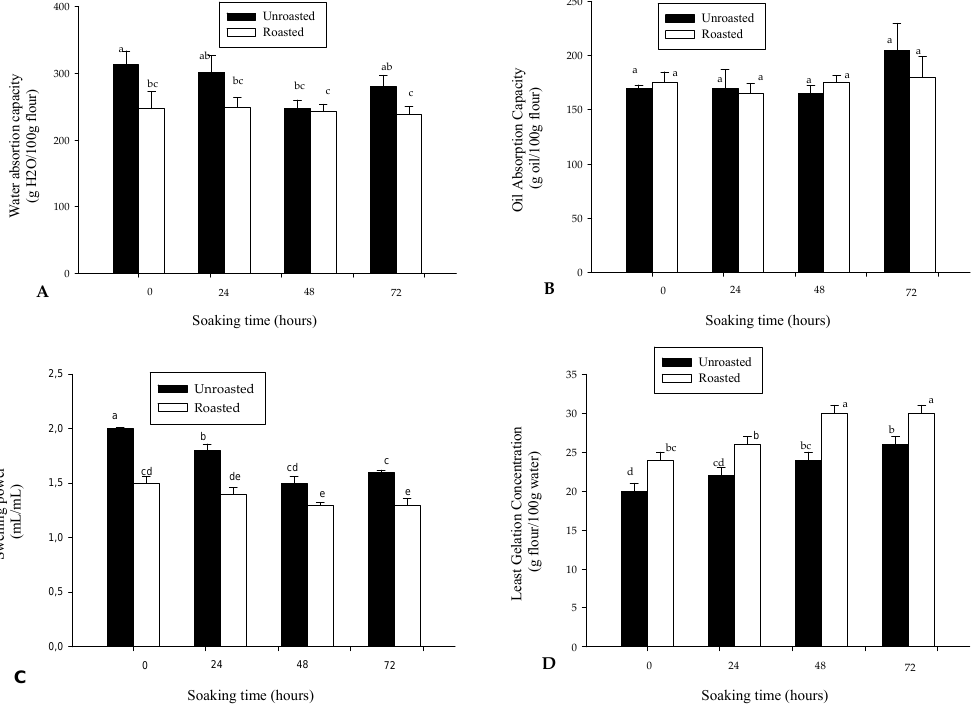
Figure 4. Variation in ( A ) Water absorption capacity; ( B ) Oil absorption capacity; ( C ) Swelling power; and ( D ) Least gelation concentration of roasted and unroasted soybean flour as a function of soaking time. Bars bearing different letters are significantly different at p < 0.05; n = 3.